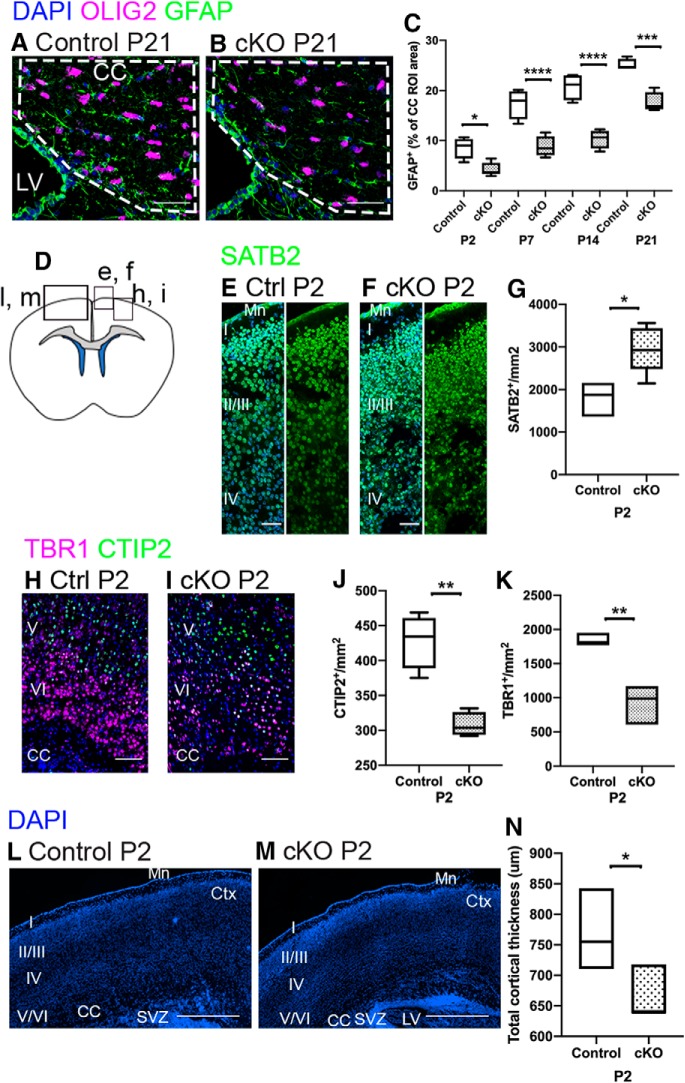
Other NSC-derived cell types are reduced by loss of RALDH2. A, B, Control and cKO mice both have GFAP+ expression in the CC (dotted lines). OLIG2 marks OL lineage cells and is included to provide contrast. C, The area of CC that is labeled by GFAP is significantly reduced in cKO mice relative to controls at all time points examined. D, Coronal section illustrating the regions imaged in E, F, H, I, L, M. E–G, cKO mice have significantly more SATB2+ neurons (green) than controls. H, I, cKO mice have significantly fewer layer 6 (TBR1, magenta) and layer 5 (CTIP2, green) neurons than control mice at P2. J, Quantification of CTIP2+ cell reduction in cKO mice. K, Quantification of TBR1+ cell reduction in cKO mice. L, M, Cortical thickness is reduced in cKO mice. N, Quantification of cortical thickness. CC, corpus callosum; LV, lateral ventricle; Ctx, cortex (with layers 1–6 in roman numerals); SVZ, subventricular zone; Mn, meninges; cKO, conditional knock-out. Scale bars: 200 μm (L, M), 100 μm (A, B), 50 μm (H, I), and 25 μm (E, F). Box and whisker plot, box: 25th and 75th percentile, whiskers: minimum to maximum value, line at median. Floating bar plot, box: minimum to maximum value, line at median. *p < 0.05, **p < 0.01, ***p < 0.001, ****p < 0.0001.